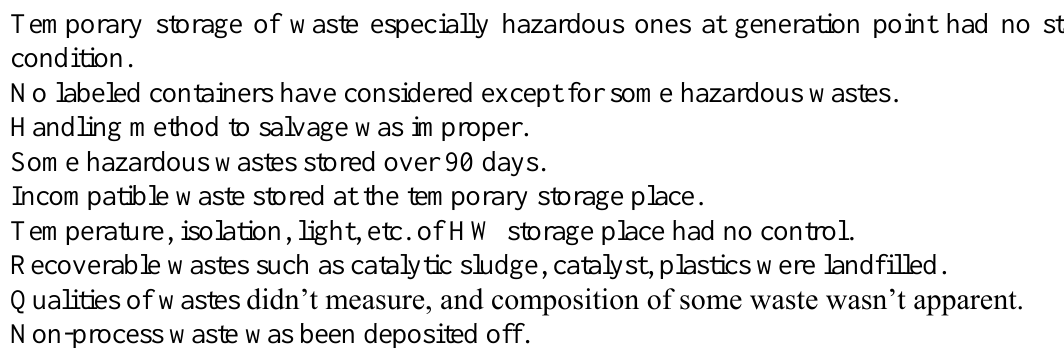
Table 2: Current situation of waste management in Amirkabir petrochemical complex Recovery%